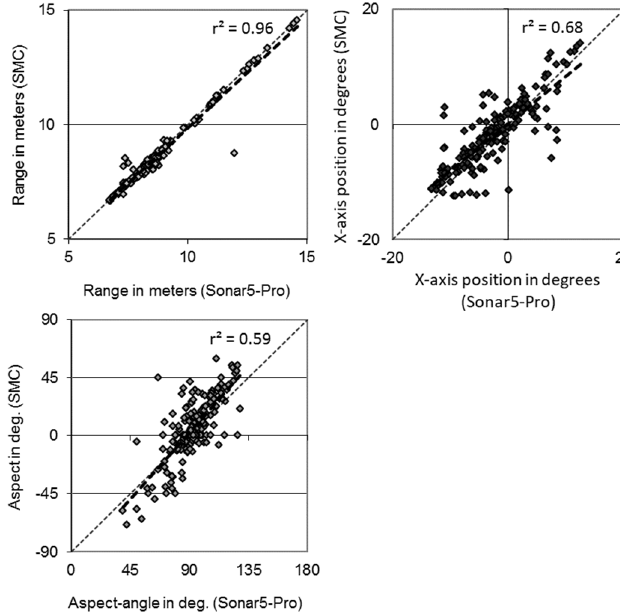
Fig. 4. Correlation between parameters exported from SMC software and those exported by Sonar5-Pro software for the same fi sh ( n =179). From left to right: detection range (m); angular X-axis position (degrees); fi sh body angle in the beam (degrees); 90 ° aspect angle means that the fi sh body was perpendicular to the central DIDSON beam.